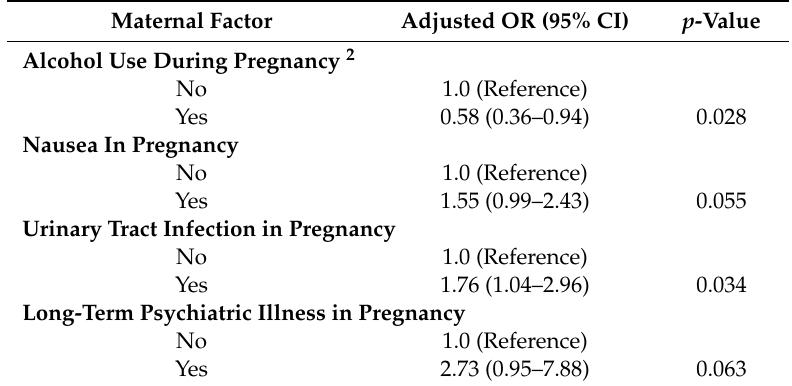
Table 3. Adjusted odds ratio (OR) for intentional avoidance of prescribed medication in pregnancy 1